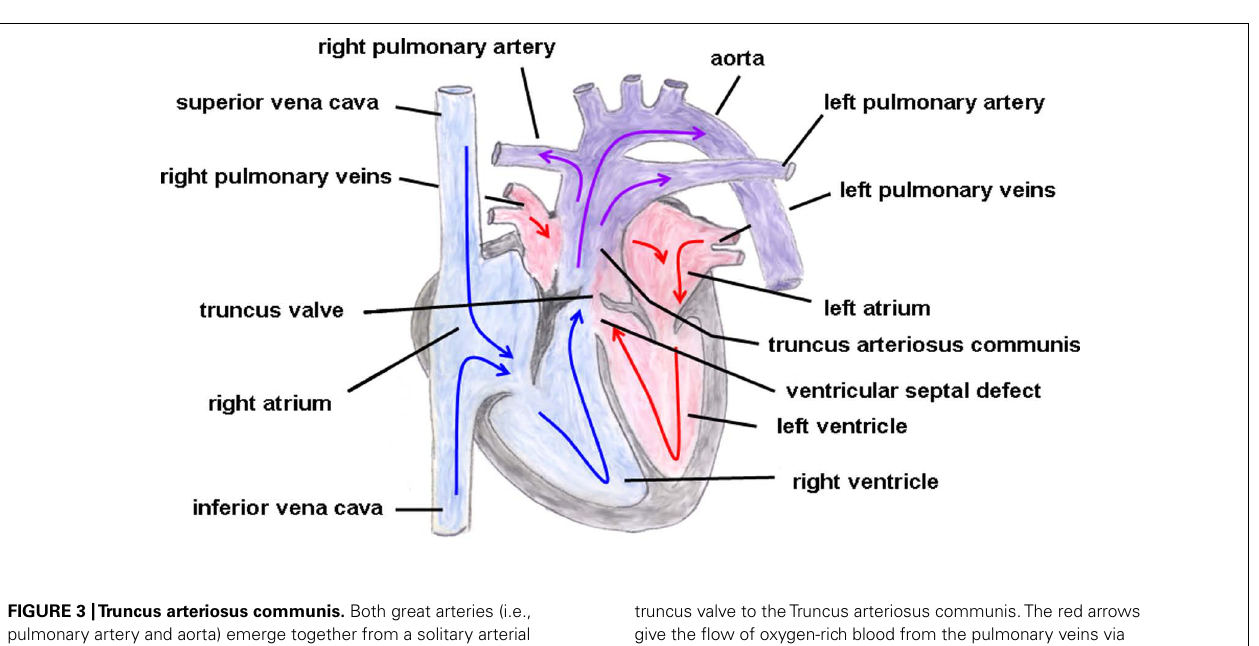
truncus valve to theTruncus arteriosus communis.The red arrows give the flow of oxygen-rich blood from the pulmonary veins via the left atrium and the left ventricle to theTruncus arteriosus